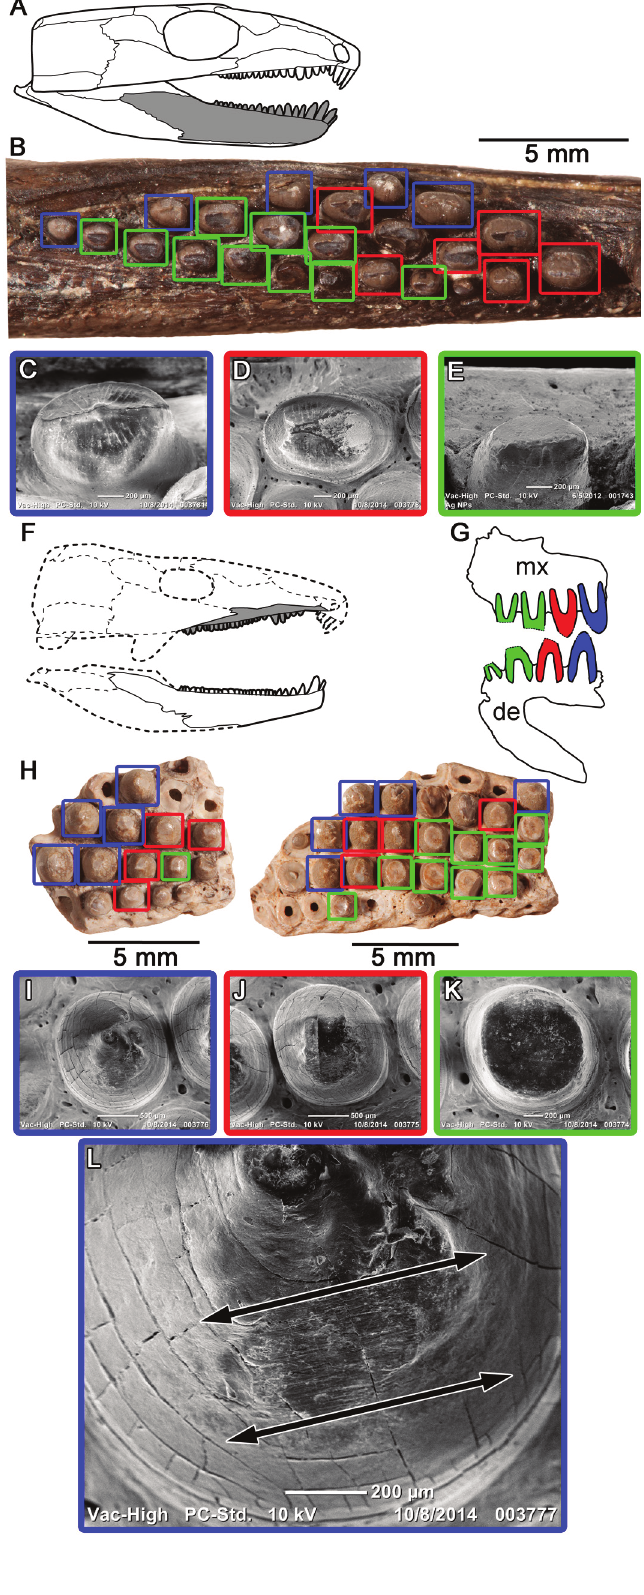
Figure 7. Comparisons of dental wear patterns be- tween Captorhinus aguti and Captorhinikos valensis . A, Reconstruction of the skull of Captorhinus aguti (modified from Heaton 1979); B, Closeup image of the multiple-rowed area of a right dentary of C. aguti from Richards Spur (OMNH 15138) showing positions of unworn (blue), lightly worn (red), and heavily worn (green) teeth. Lingual is towards the top of the page, anterior is to the right; C, SEM image of an un- worn tooth of C. aguti ; D, lightly worn tooth; E, heavily worn tooth; F, reconstruction of the skull of Ca. valensis (modified from Reisz 2006); G, interpretation of dental wear patterns across the maxilla and dentary of Ca. valensis ; H, dental wear patterns along the posterior portion of a left maxilla (OMNH 77538). Note that unworn teeth (blue) tend to be restricted to the distal ends of each tooth row; I, dental wear patterns along the multiple-rowed area of a partial left maxilla (OMNH 77532). The heaviest tooth wear (green) is concentrated along the mesial ends of each tooth row; I, SEM image of very lightly worn maxillary tooth with lingual and labial wear facets; J, SEM image of lightly worn maxillary tooth with a single large wear facet extending to the tip of the crown; K, heavily worn tooth; L, striations along the labial surface of a lightly worn tooth crown indicate fore and aft motion between upper and lower